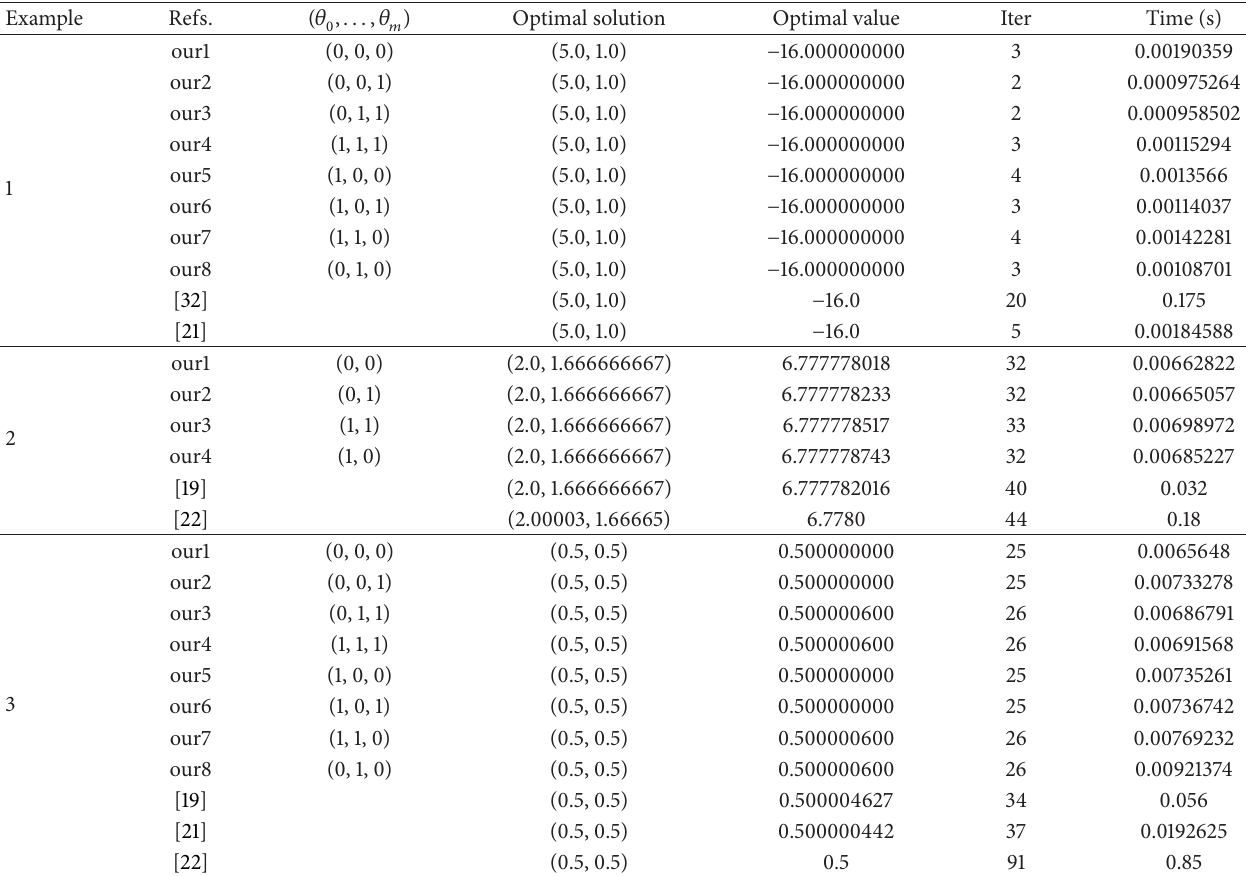
Table 1: Numerical results for Examples